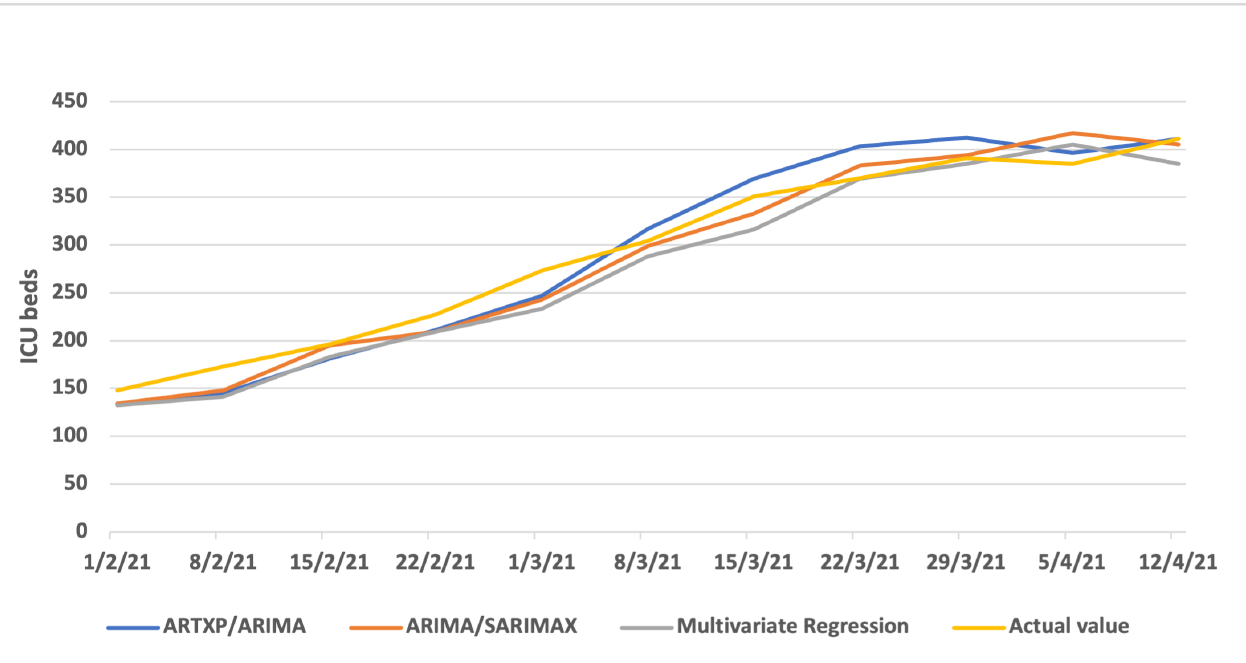
Figure A10. One week Predicted vs. Actual